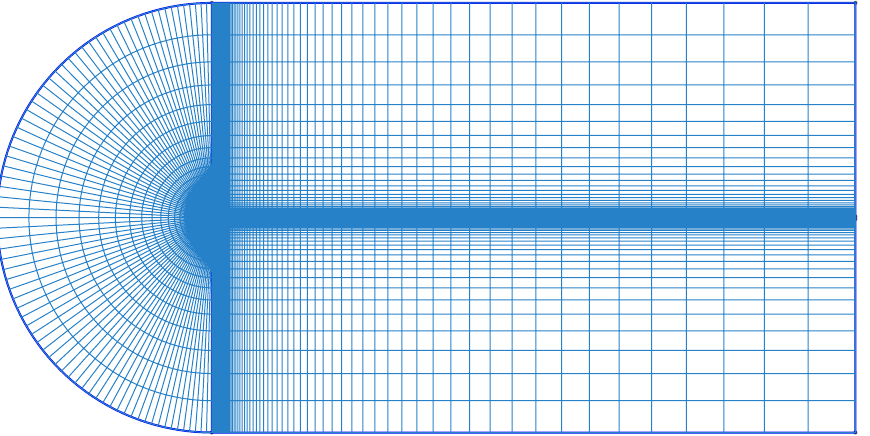
Figure 4. Mesh generation.